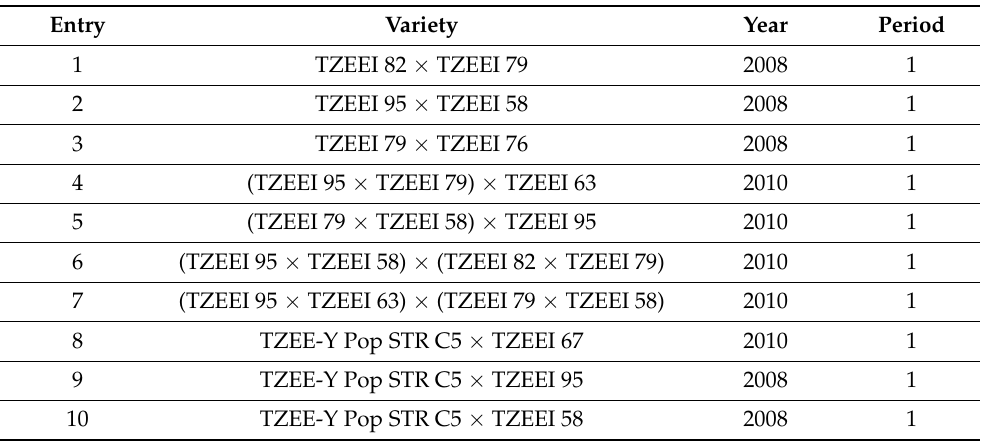
Table 1. Extra-early maturing maize hybrids used for the genetic gain study and the period of